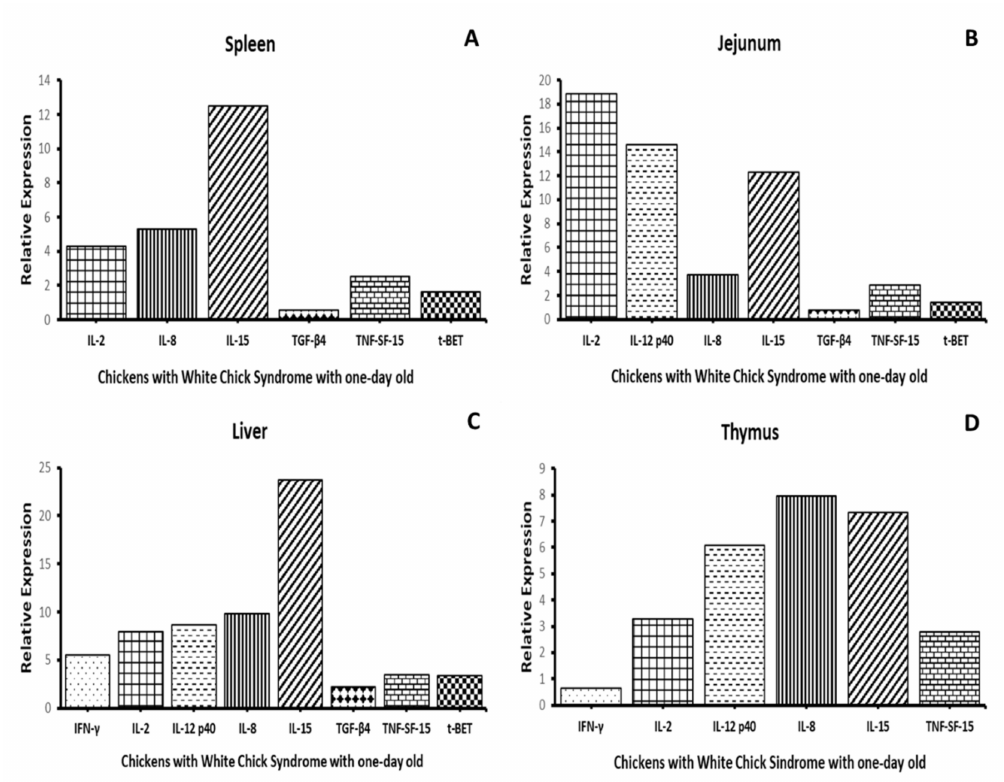
Figure 5. Relative gene expression of cytokines. Relative gene expression of IFN- γ , IL-2 , IL-8 , IL-12 p40 , IL-15 , TGF- β 4 , TNF-SF-15 and t-BET in the spleen ( A ), jejunum ( B ), liver ( C ) and thymus ( D ) of chicks naturally a ff ected with white chick syndrome. The data represent the mean gene expression levels of the target genes in five biological replicates relative to the housekeeping gene β -actin